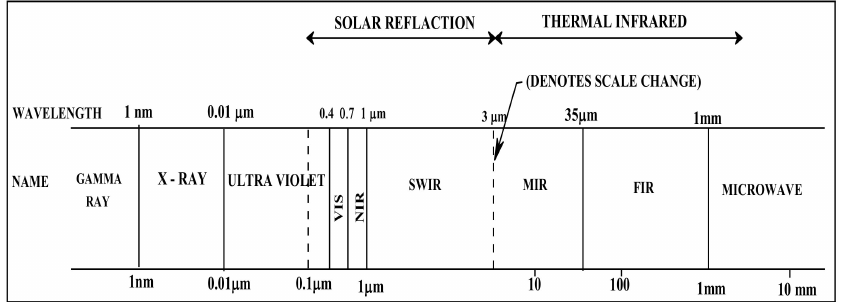
Figure 8. Different parts of electromagnetic (EM)